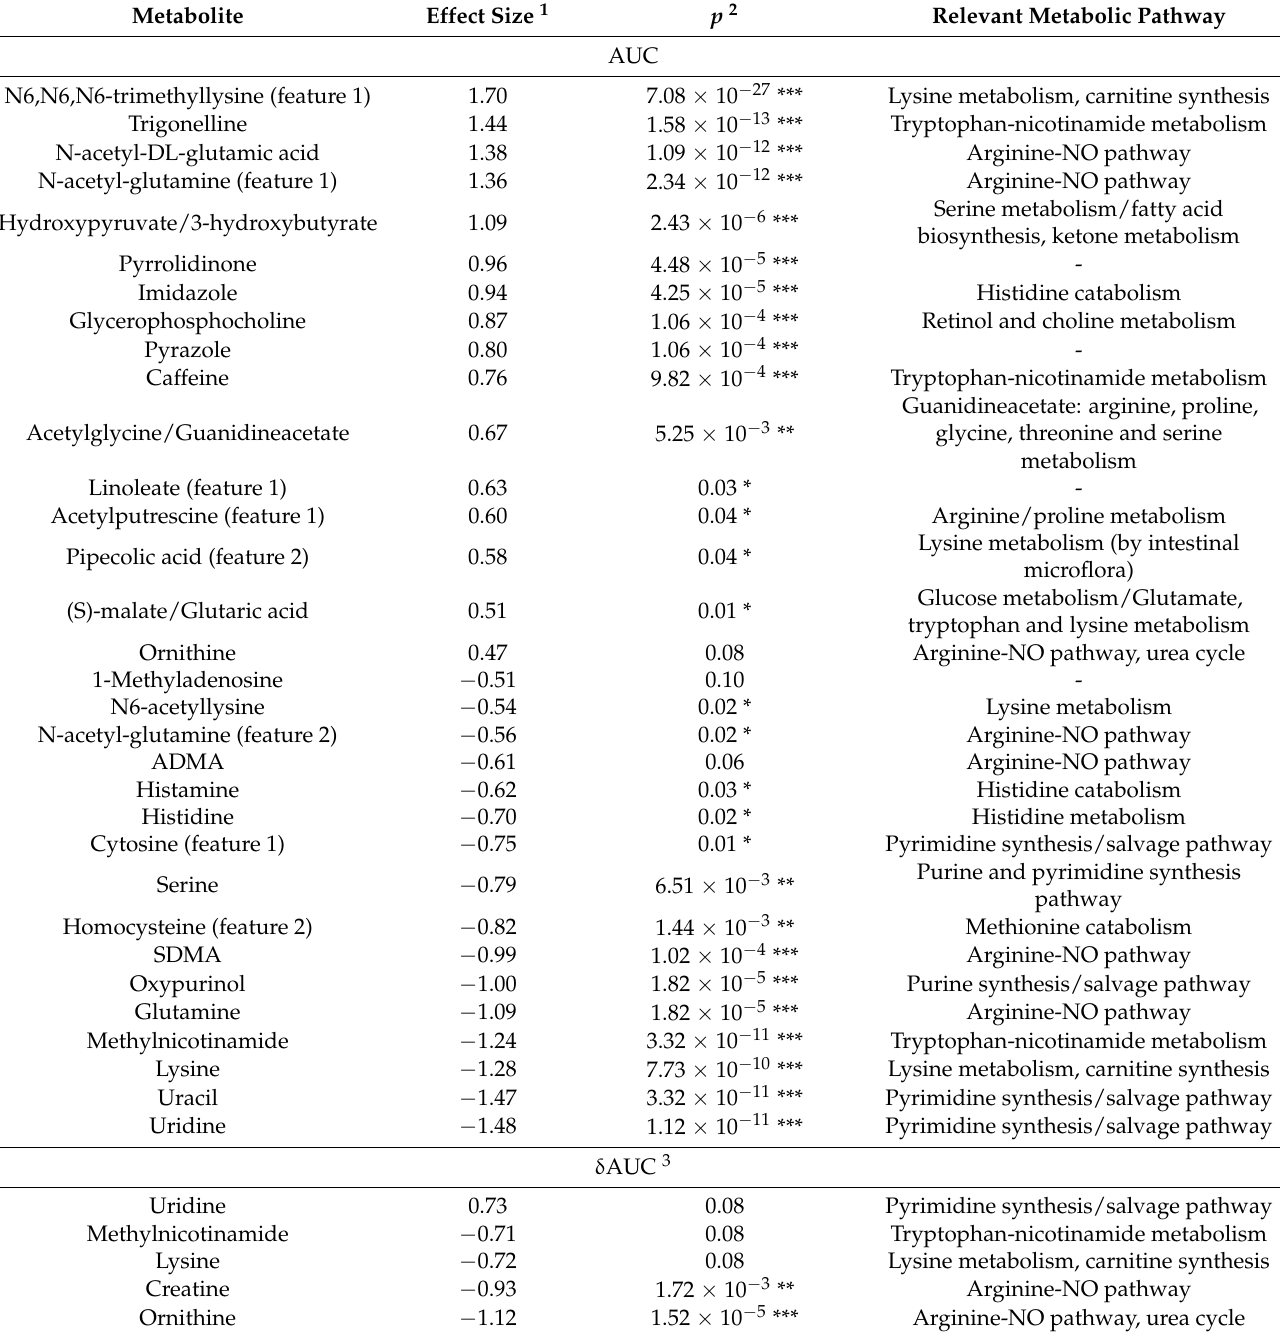
Table 1. Differences in AUC and δ AUC between dinner and